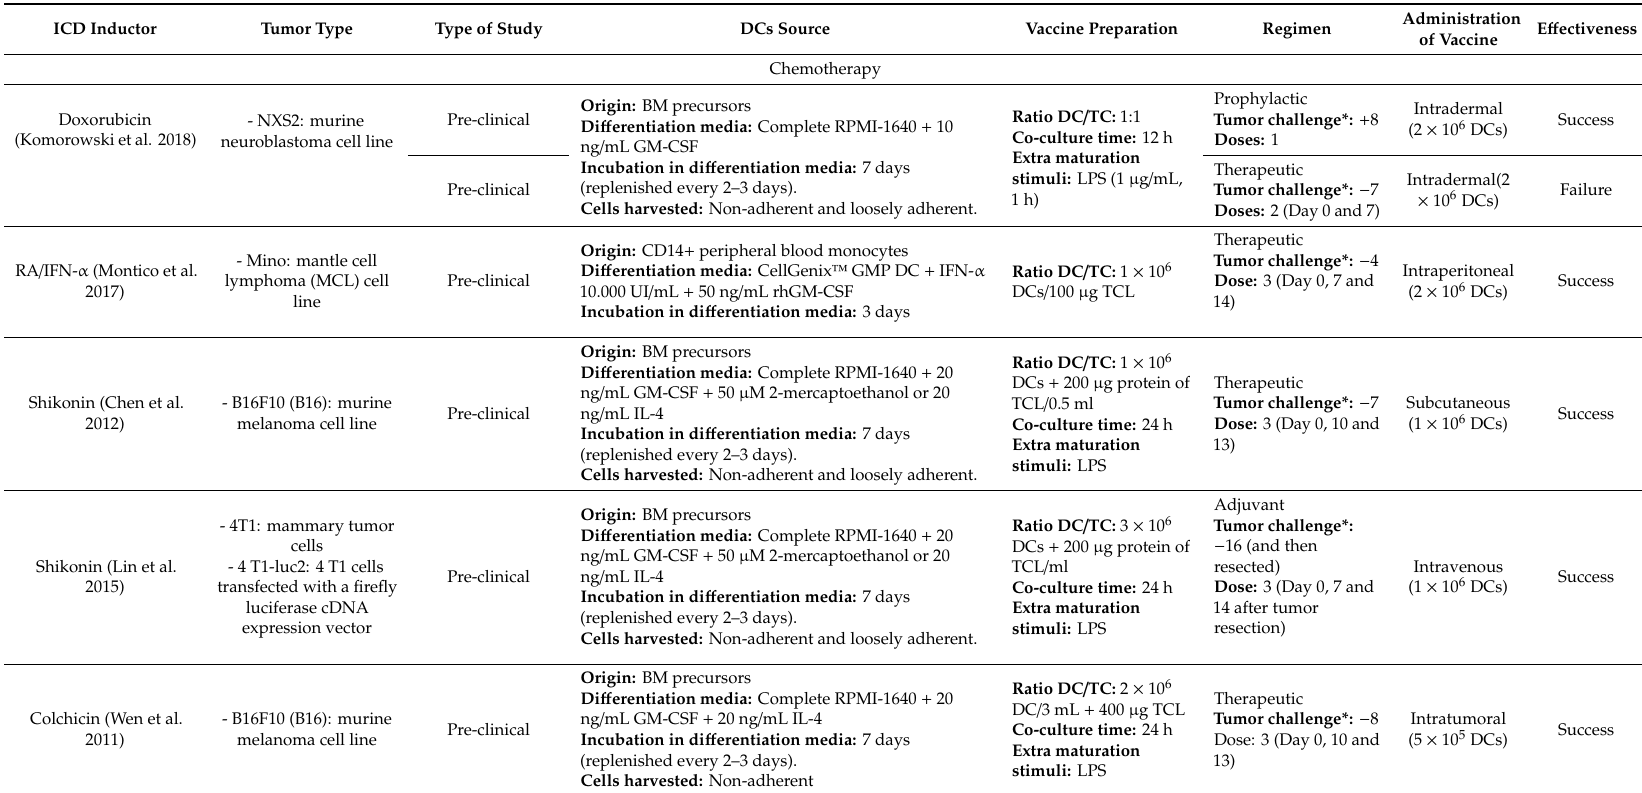
Table A1. ICD inducing therapies used for the preparation of DC